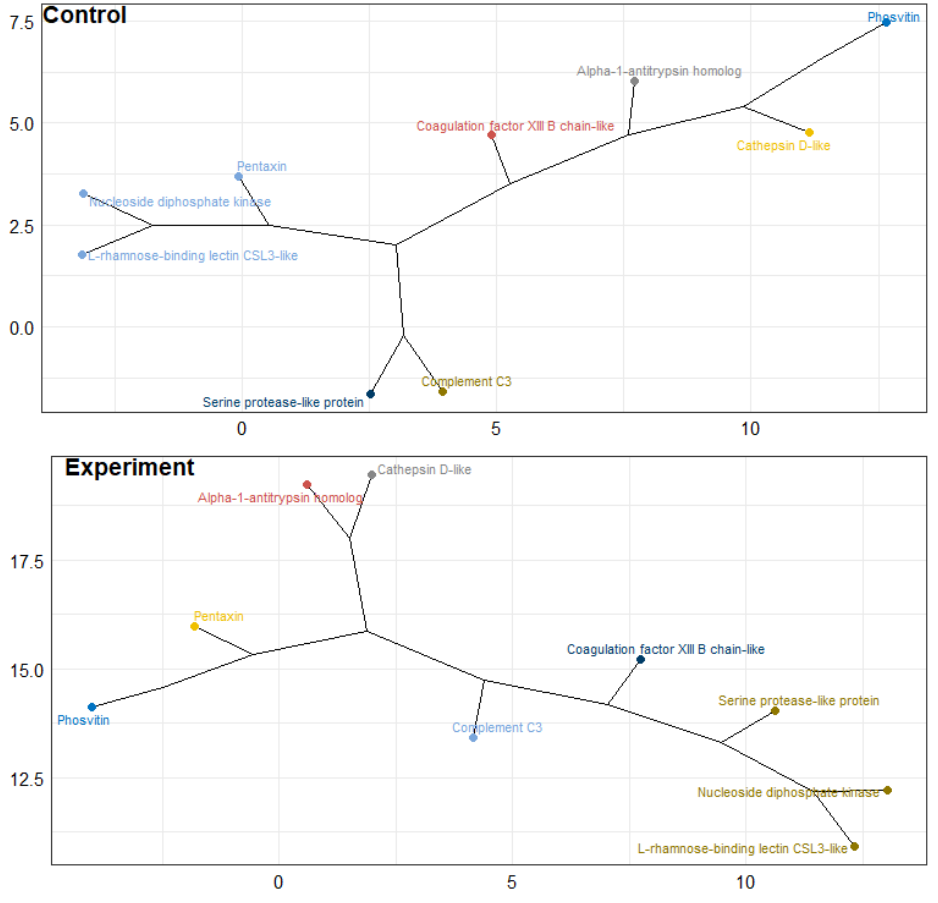
Figure 10. Hierarchical clustering visualizing as a “phylogenetic tree dendrogram” for control and experimental groups of Atlantic salmon eggs ( Salmo salar L.). Note: 7 clusters are found out.